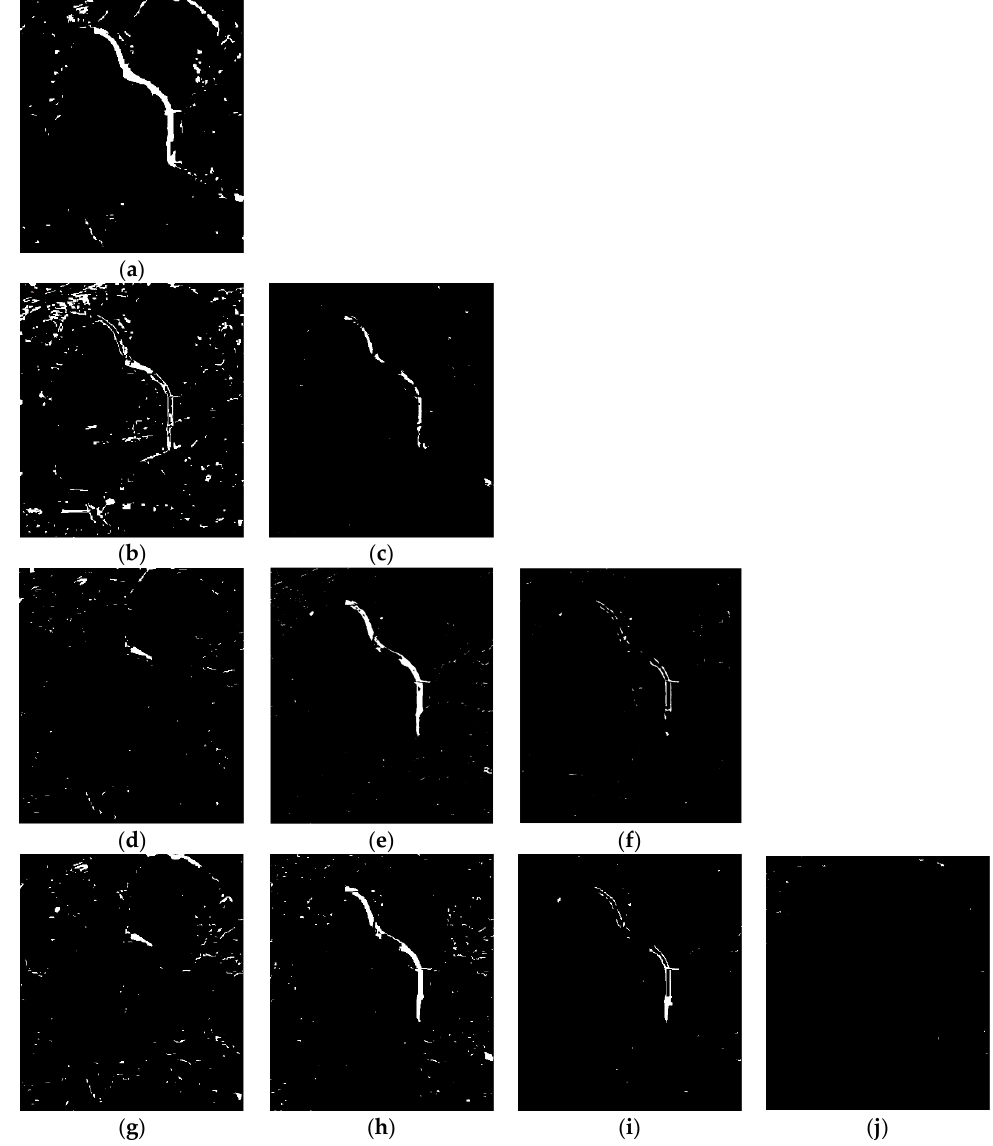
Figure 12. Time-series change detection over tunnel of East Lake from 2011 to 2017 ( a ) between December 2011 and June 2015. ( b ) Between December 2011 and July 2016. ( c ) Between June 2015 and July 2016. ( d ) Between December 2011 and April 2017. ( e ) Between June 2015 and April 2017. ( f ) Between July 2016 and April 2017. ( g ) Between December 2011 and May 2017. ( h ) Between June 2015 and May 2017. ( i ) Between July 2016 and May 2017. ( j ) Between April 2017and May 2017. To give a visual impression of the results, Figure 12 shows the time-series change detection